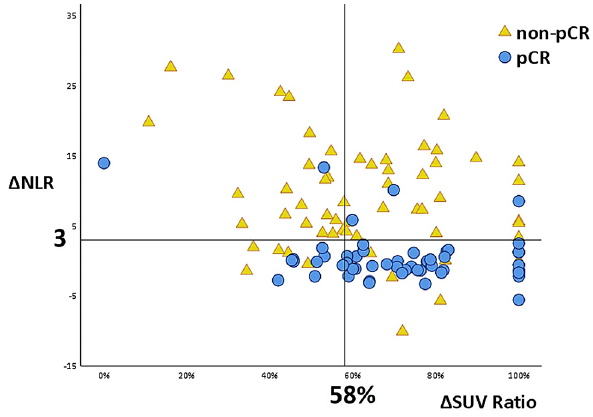
Figure 1. Distribution of ΔNLR and ΔSUV ratio in patients with or without pCR. ΔNLR the change of neutrophil-to-lymphocyte ratio, pCR pathological complete response, OS overall survival, PFS progression-free survival, ΔSUV ratio the change in maximum standardized uptake value at 1 h.